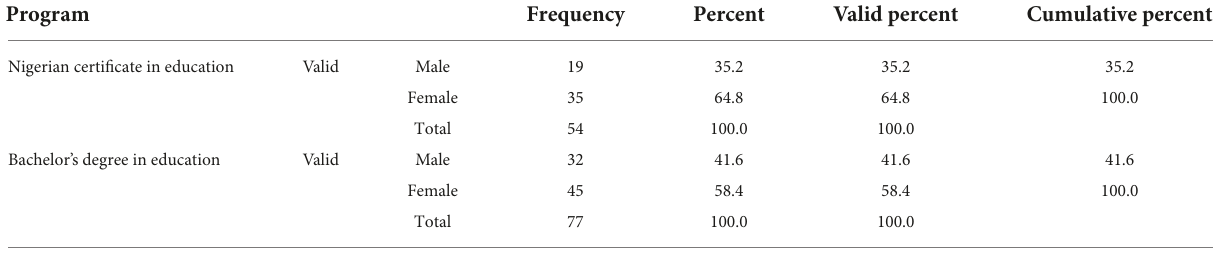
TABLE 1 Demographic characteristics of study participants.